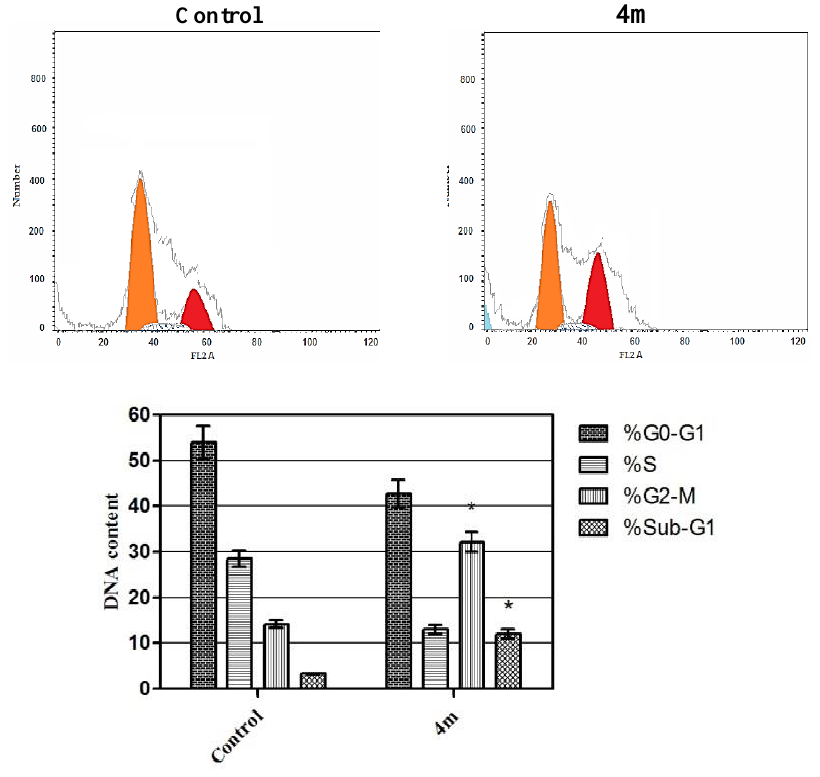
Figure 4. Effect of compound 4m on the phases of cell cycle of MDA-MB-231 cells. * Significantly different from control at p < 0.05. (Two-way ANOVA test).